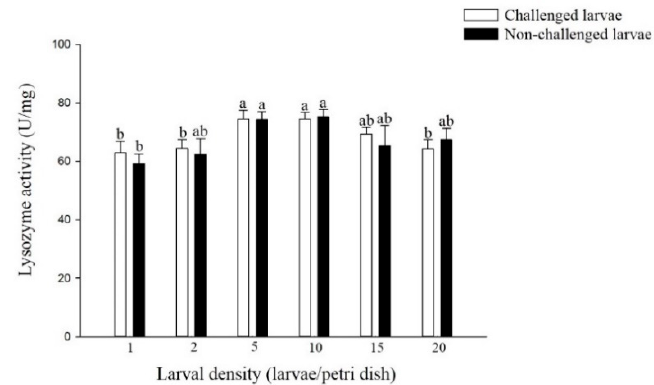
Figure 3. Lysozyme activity of larval P. xylostella reared at different larval densities. Bars of non-challenged (or challenged) larvae with the same letter are not significantly different at the 0.05 level by Tukey’s HSD multiple comparison. The asterisk indicates a significant difference at the 0.05 level by Student’s t -test between the non-challenged and challenged groups.